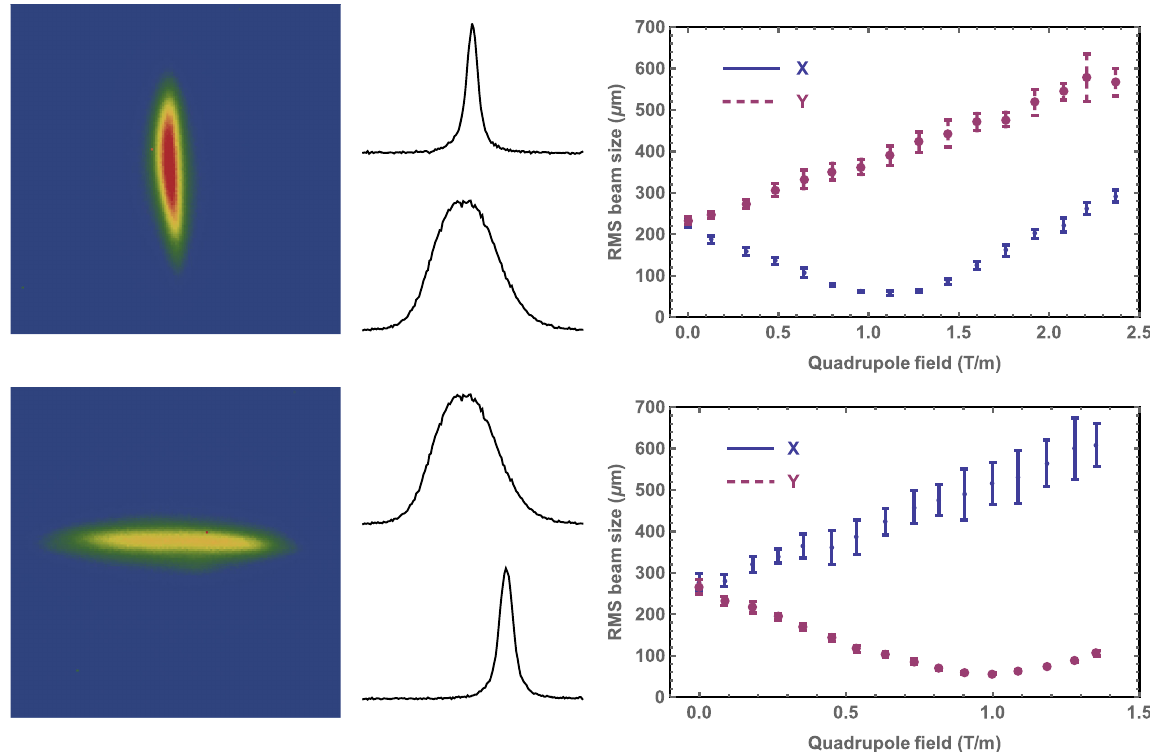
8. YAG screen images with lineouts from quadrupole scan for X emittance calculation above, and independent Yemittance scan below. RMS beam size as a function of quadrupole field strength used for Twiss parameter